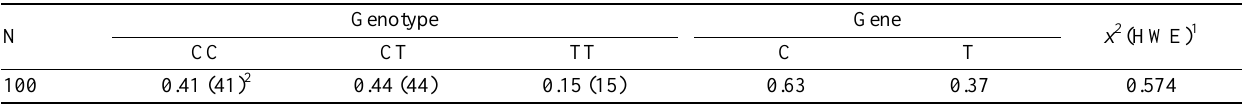
Table 4. Genotype and gene frequencies of the c.*2041T>C single nucleotide polymorphism in the 3′ untranslated region of the stearoyl- CoA desaturase gene in Berkshire pigs Genotype N